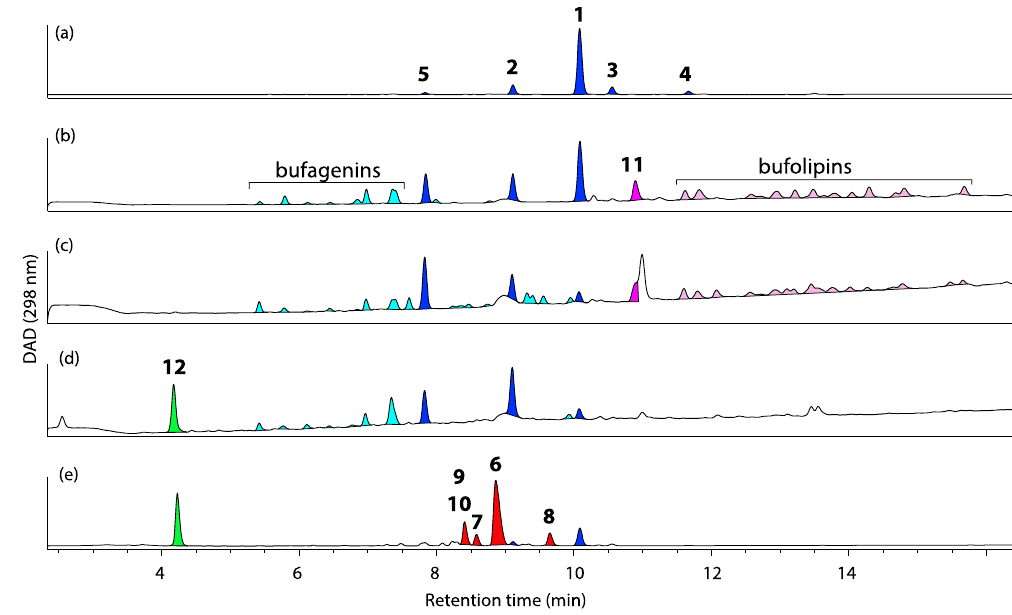
Figure 1. Analytical HPLC (298 nm) chromatogram of extracts obtained from ( a ) frozen parotoid gland, ( b ) eggs, ( c ) early-development tadpole, ( d ) late-development tadpole and ( e ) fresh parotoid secretion of cane toads, Rhinella marina [HPLC condition: Agilent Zorbax C 8 column, 5 μm, 4.6 × 150 mm, 1 mL/min flow rate 15 min gradient elution from 90% H 2 O in MeCN, to 100% MeCN, with a constant 0.01% TFA in MeCN modifier]. Highlights: light blue = unspecified bufagenins (MW 400–432); light pink = unspecified bufolipins (MW 630– 700); blue = bufagenins 1–5 ; red = bufotoxins 6–10 ; pink = bufolipin 11 . Structures for 1–11 are shown in Fig. 2, and were assigned on the basis of spectroscopic analysis and comparisons with authentic